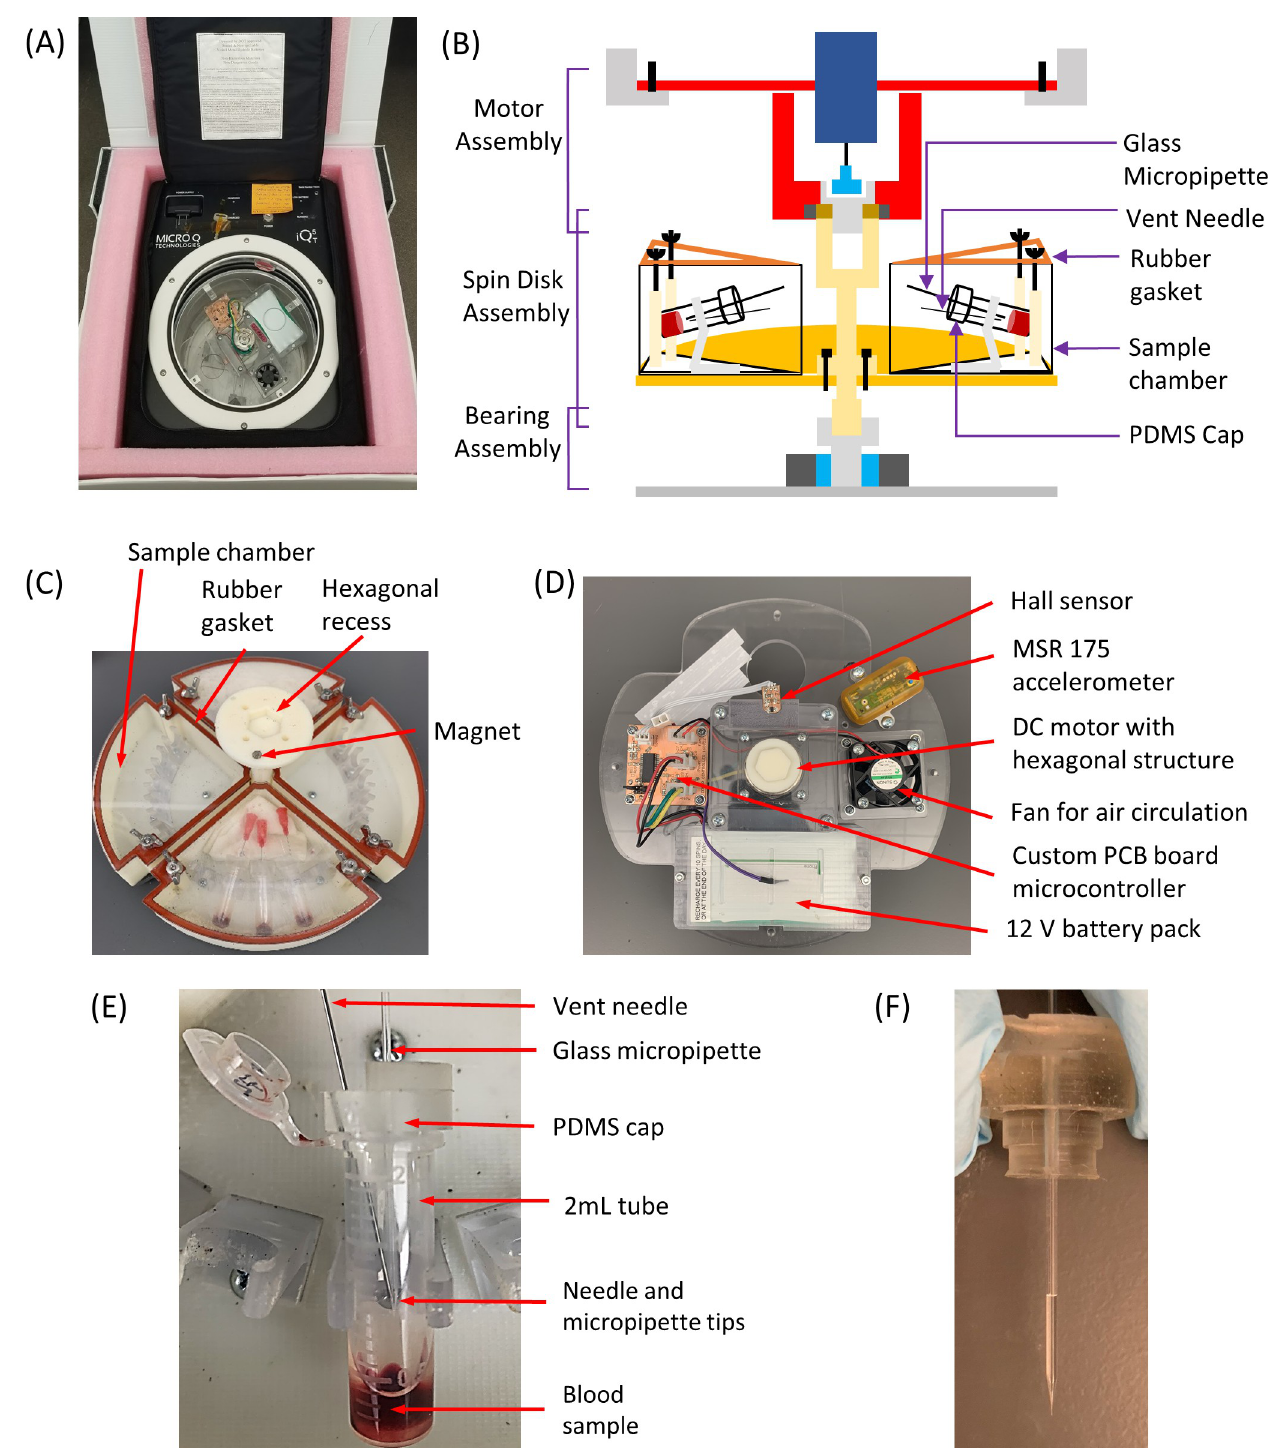
Fig 2. The Smart Shipping Incubator (SSI). (A) The custom iQ5 shipping incubator loaded with the centrifugal system; (B) Schematics of the centrifugal system: (C) a photo of the Spin Disk Assembly (SDA); (D) a photo of the Motor Assembly (MA); (E) a photo of a “Smart” Cap inserted into a sample tube loaded to a tube holder; (F) a photo of a glass micropipette loaded with cyt-B reagent.